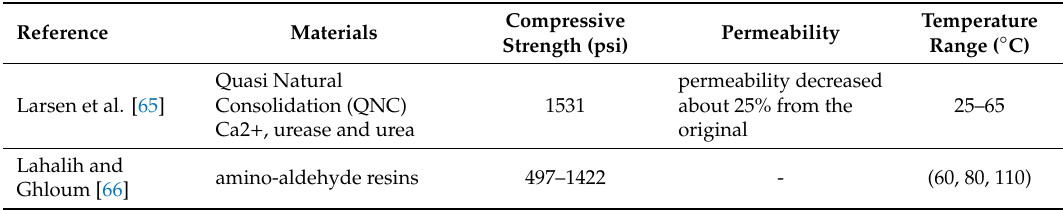
Table 7. Amino-aldehyde polymer methods to consolidate sand